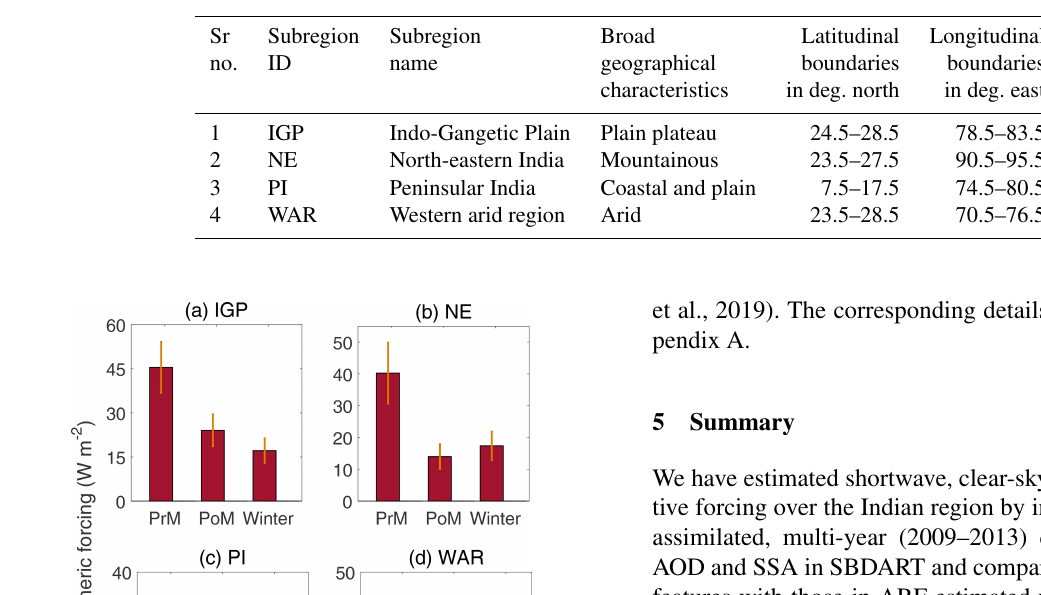
Table 2. Details of subregions considered.